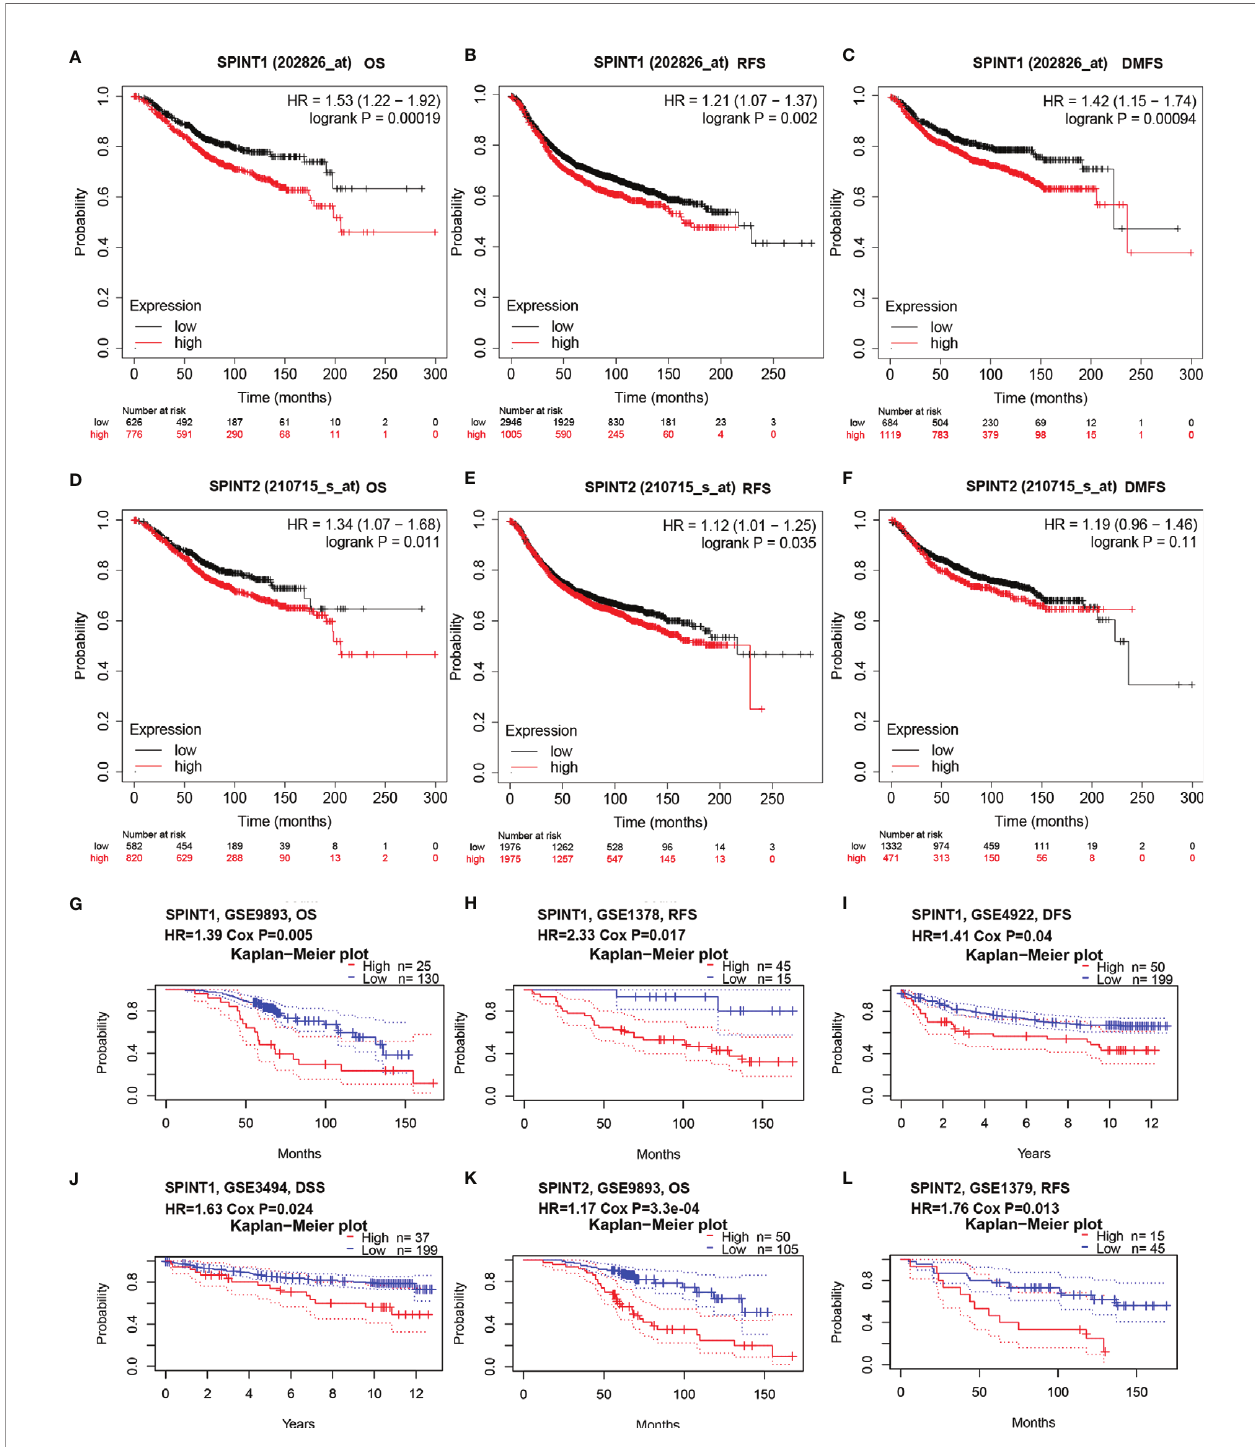
FIGURE 4 | SPINT1/2 were correlated with patient prognosis. Correlation between SPINT1 expression and OS (A) , RFS (B) and DMFS (C) from Kaplan – Meier plotter. Association between SPINT2 expression and OS (D) , RFS (E) and DMFS (F) Kaplan – Meier plotter. The correlation between SPINT1 expression and the OS from GSE9893 (G) , RFS from GSE1378 (H) , DFS from GSE4922 (I) and DSS from GSE3494 (J) . The correlation between SPINT2 expression and the OS from GSE9893 (K) and the RFS from GSE1379 (L) on PrognoScan